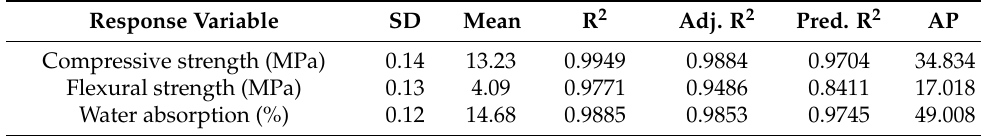
Table 7. Validation properties of response